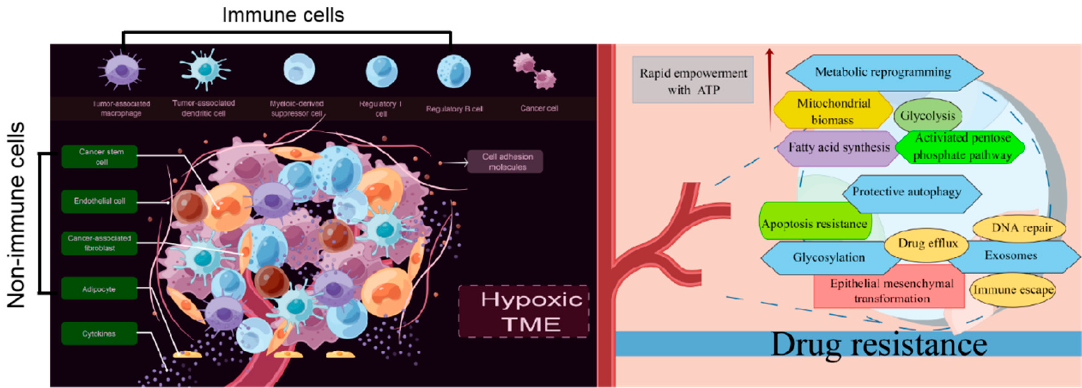
Figure 3. Drug resistance standing in cancers from the perspective of TME, metabolic reprogramming, exosomes, protein glycosylation, and autophagy ( By Figdraw ).